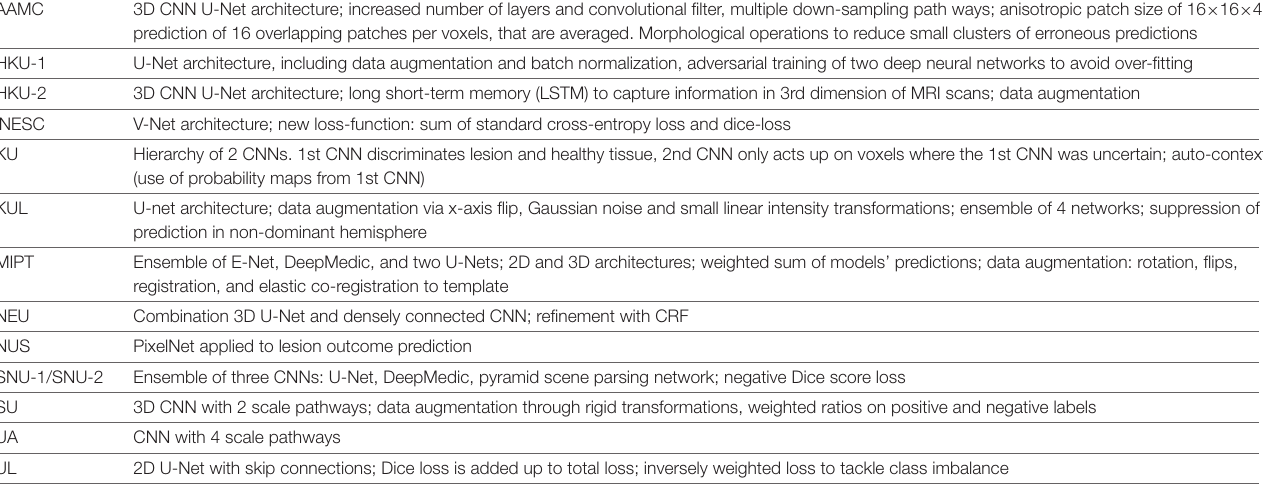
TABLE A3 | Overview of methods of participants of ISLES